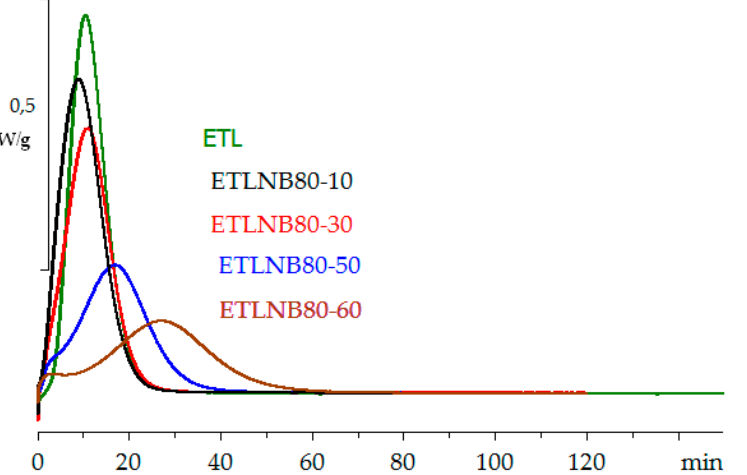
Figure 4. Isothermal DSC cure curves for ETL (green), ETLBN80-10 (black), ETLBN80-30 (red), ETLBN80-50 (blue), and ETLBN80-60 (brown) at 70 °C. Exothermic direction is upward. The peak height decreases with increasing BN content.